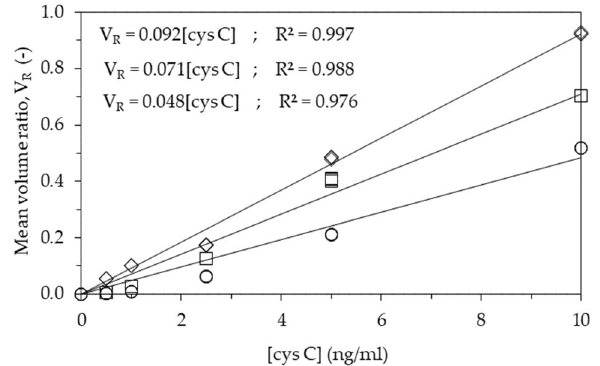
Figure 7. Calibration curve for the detection of Cys-C using LFA cartridges that feature Alexa-labeled Fab fragments and anti-Cys-C capture antibodies anchored via ZZ-CBM3 on analytical strips made of NC with layered cellulose ( ◇ ) and NC alone ( □ ). For comparison purposes, the same standards were run in LFA cartridges with the conventional LFA architecture ( ○ )—analytical strip made of NC, anti-Cys-C capture antibodies adsorbed on test line and detection with Alexa-labeled full-length antibodies. The ratio of pixel volume of test line and control line (V R = V T /V C ) is plotted as a function of the concentration of Cys-C ([cys C]). The experiments were run in triplicate and data were fitted by linear regression. Regression equations are shown for the new, intermediate and conventional architecture (top to bottom).